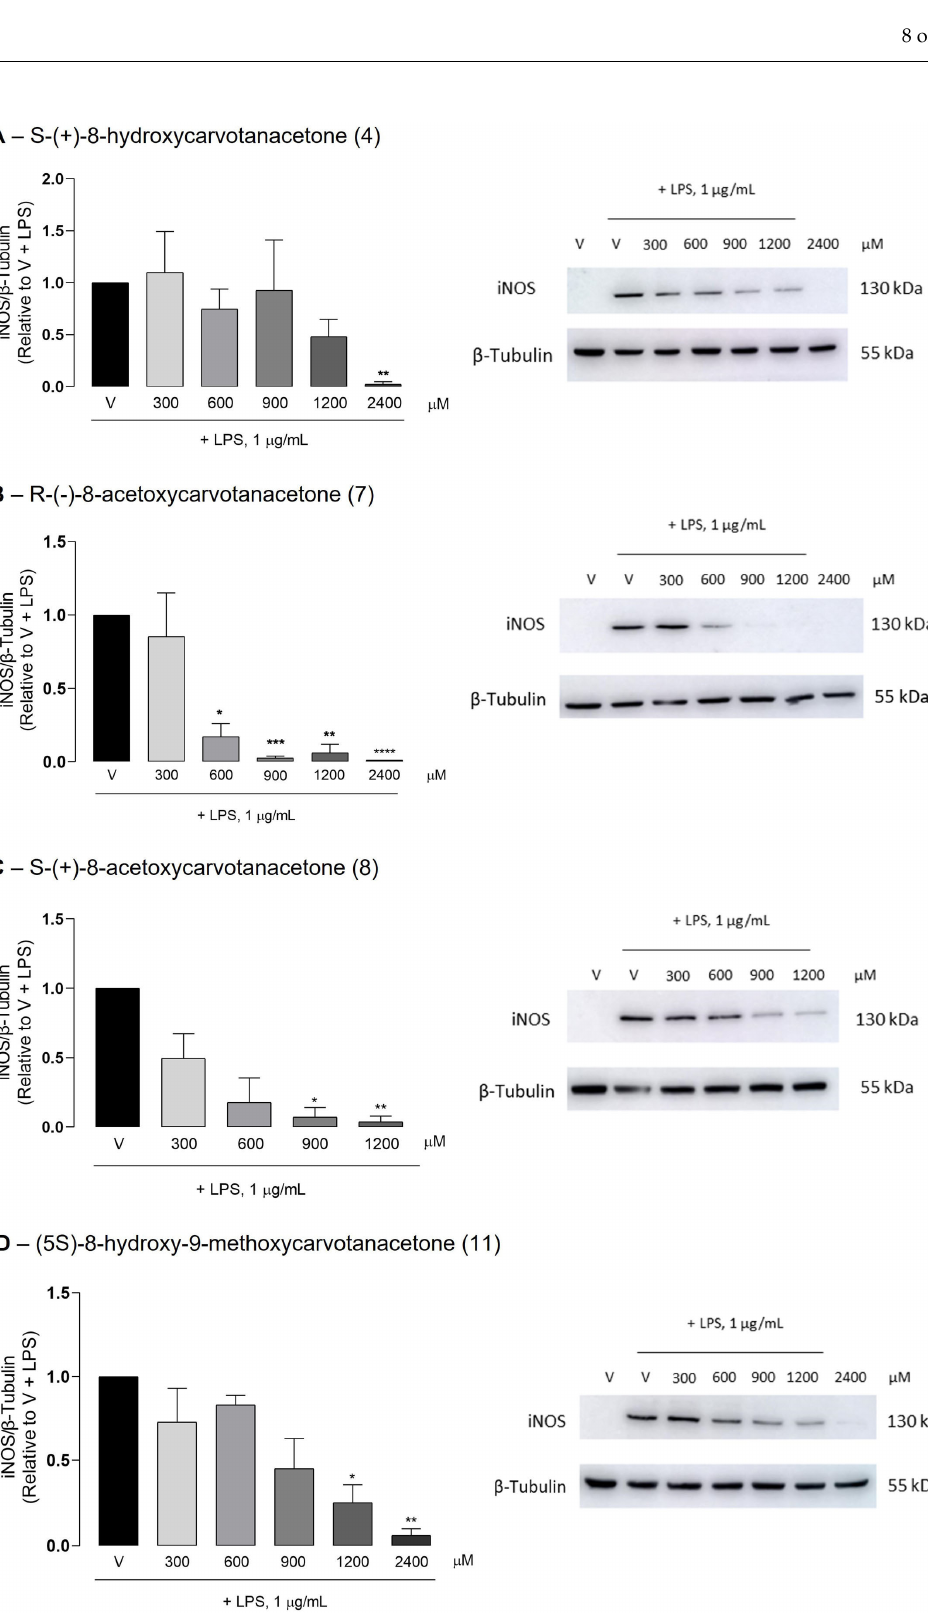
Figure 3. Inhibition of the LPS-induced iNOS protein levels by the test compounds. Raw 264.7 macrophage cultures were treated with 1 µ g/mL LPS for 18 h, following pretreatment with the vehicle (0.1% DMSO) or the indicated concentrations of the test compounds. The control cells (V) were treated with vehicle alone (0.1% DMSO) in the absence of LPS. Representative images of Western blots are shown. Images of the full-length blots are provided in Supplementary Material (Figures S25 ‐ S28). Each column represents the mean ± SEM of three independent experiments. * p < 0.05, ** p < 0.01, *** p < 0.001 and **** p < 0.0001 relative to the LPS ‐ treated cells.